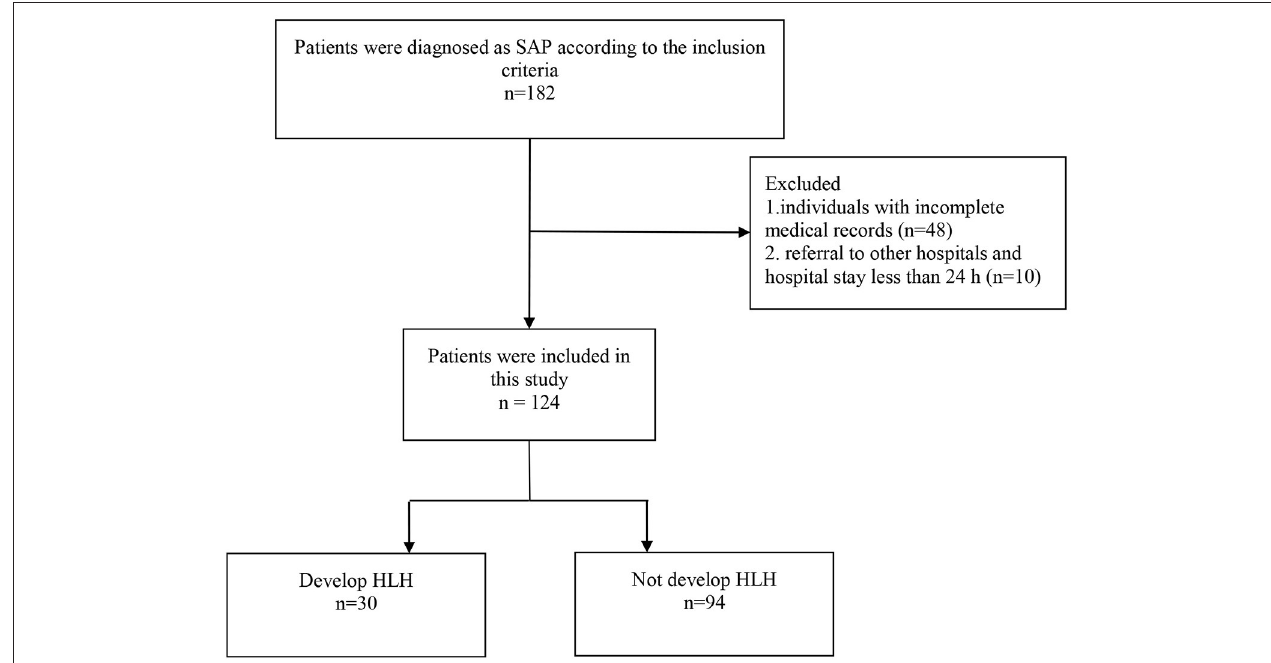
FIGURE 1 | Patients included in the study